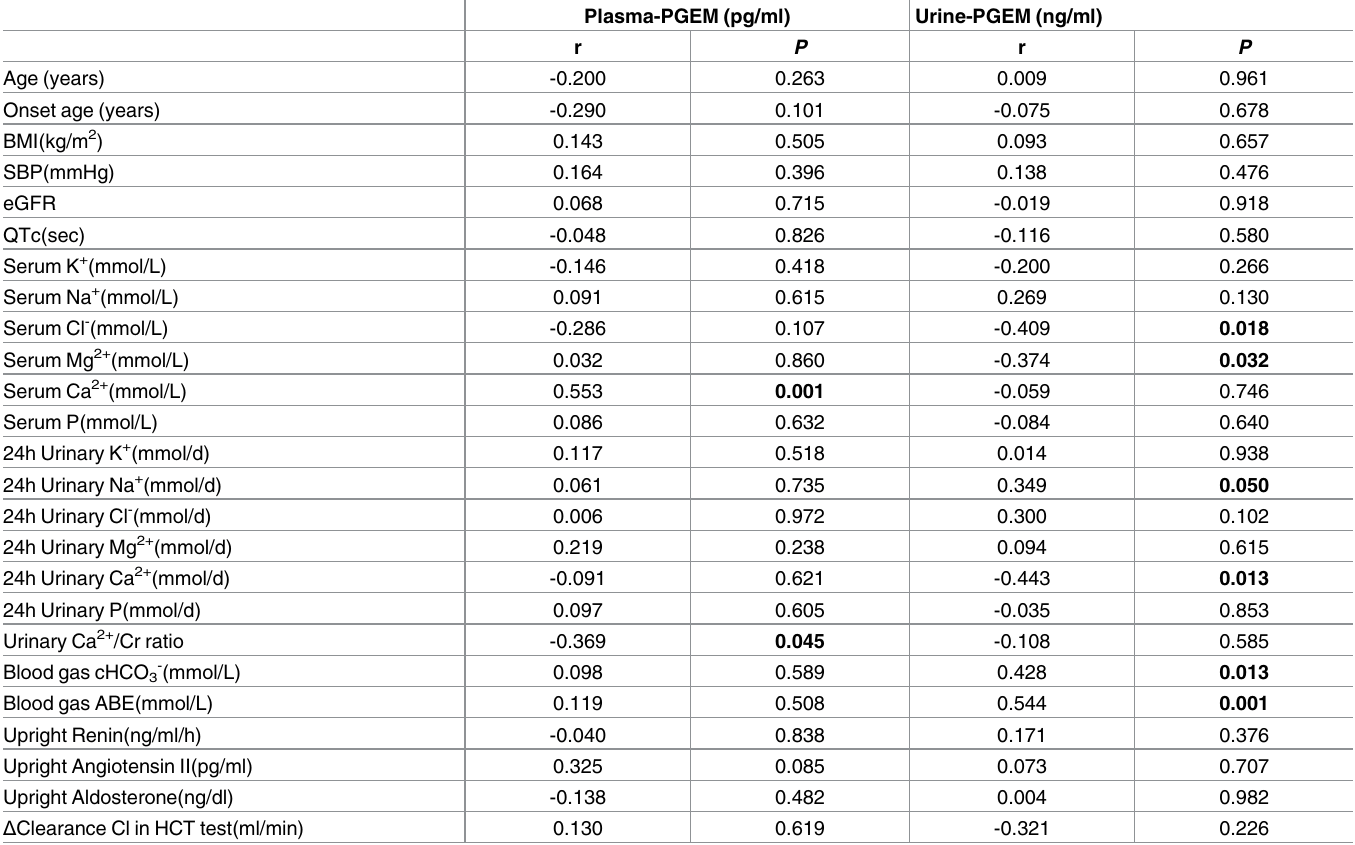
Table 2. Linear correlation analyze among prostaglandin E2 metabolite concentration and clinical